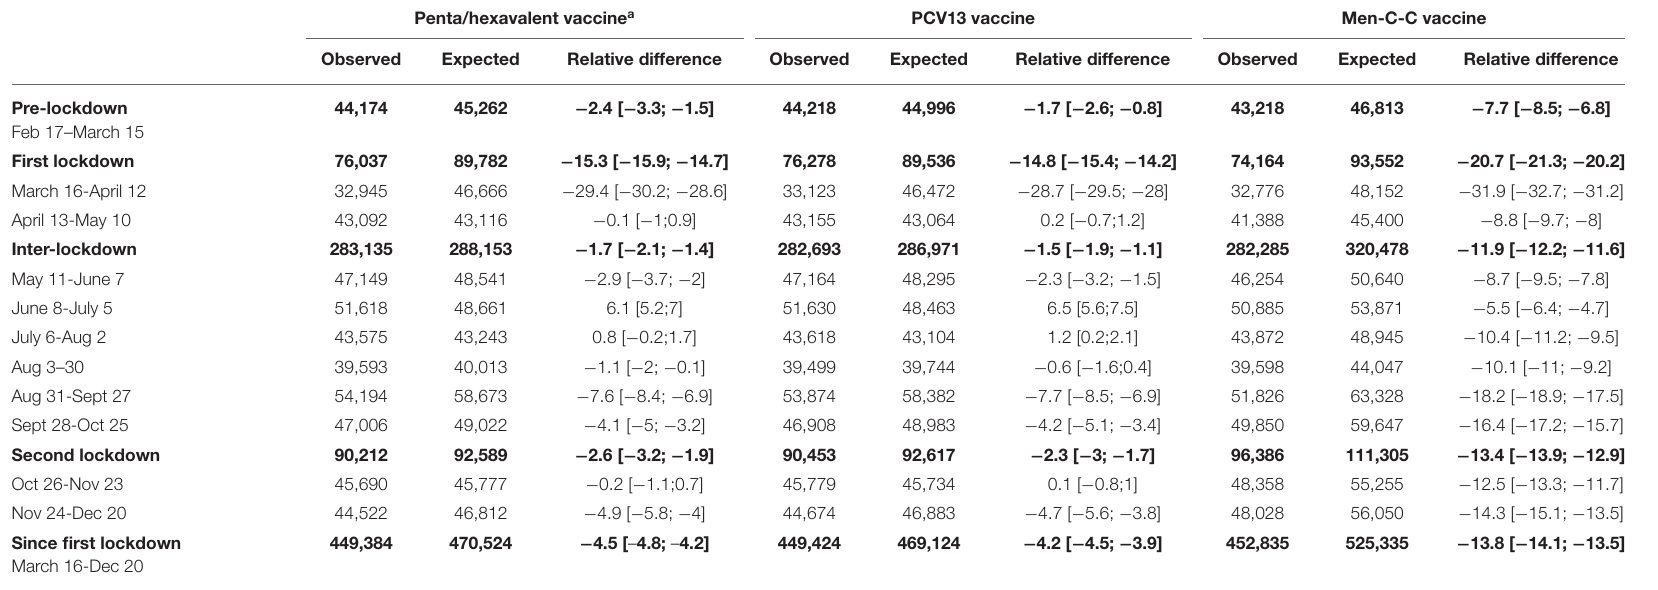
TABLE 2 | Relative differences between the observed and expected booster counts for penta/hexavalent, 13-valent pneumococcal conjugate (PCV13), and meningococcal conjugate type-C (Men-C-C) vaccines during the COVID-19 pandemic in France in